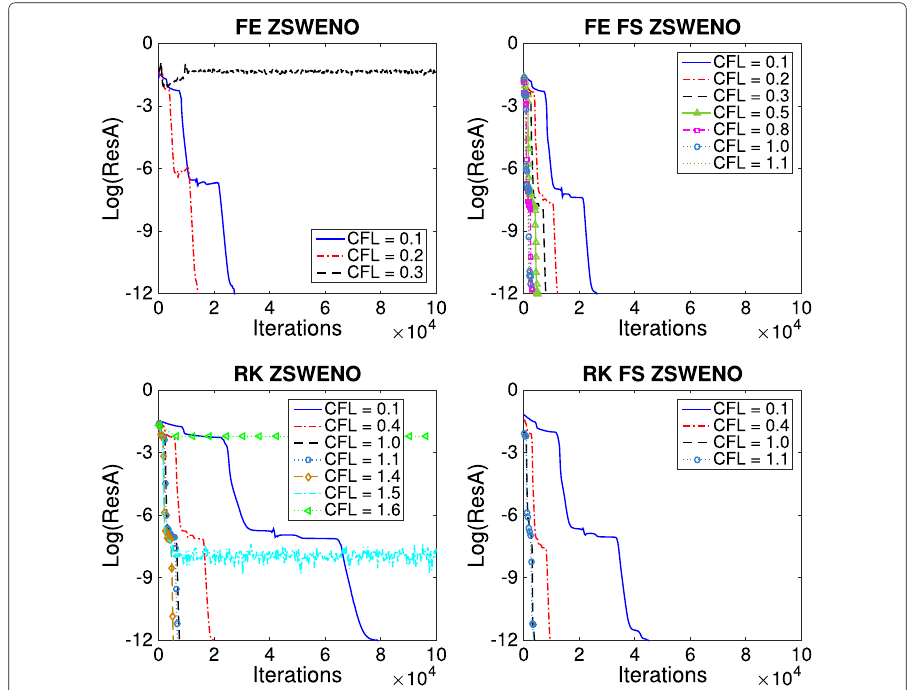
Fig. 9 Reproduced from [37]. The evolution of the average residue in terms of iterations of the 1D steady shock by various ZSWENO schemes and CFL